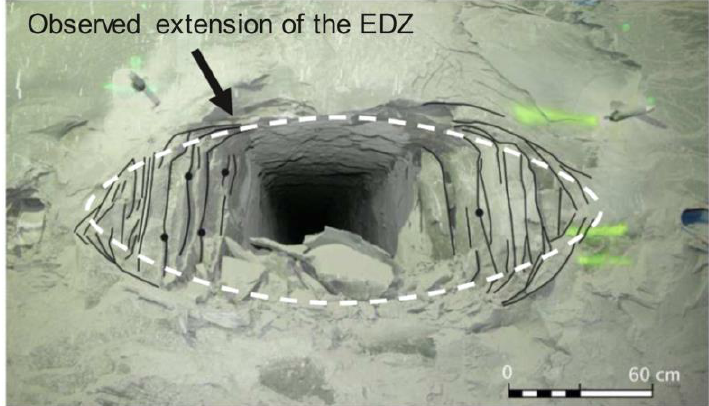
Table 2. Mechanical parameters used for the COx claystone.